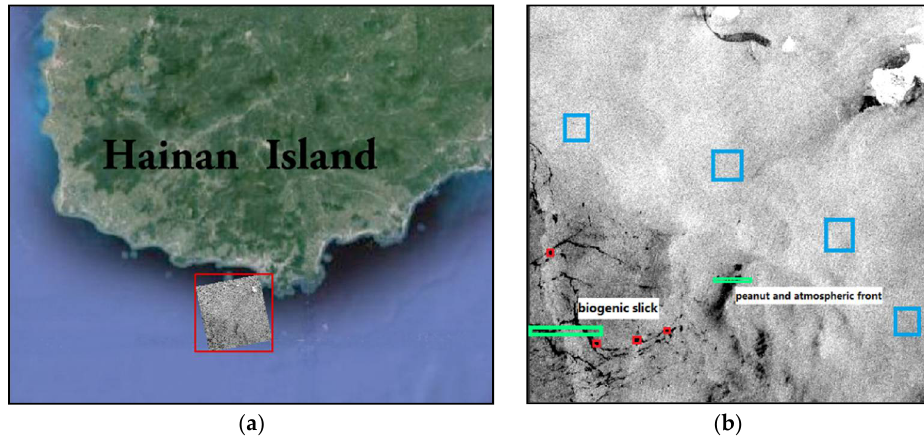
Figure 3. The scene of RADARSAT-2 acquisition (18 September 2009), showing natural and simulated (peanut oil) biogenic slicks: ( a ) Location of the acquired image; ( b ) Intensity images (σ VV ).